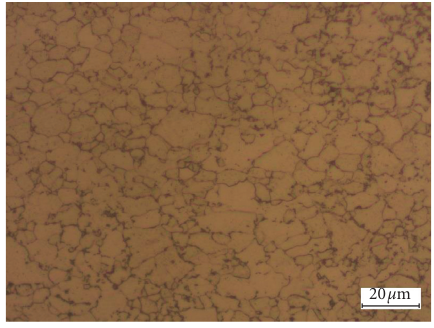
Figure 1: Metallographic structure.